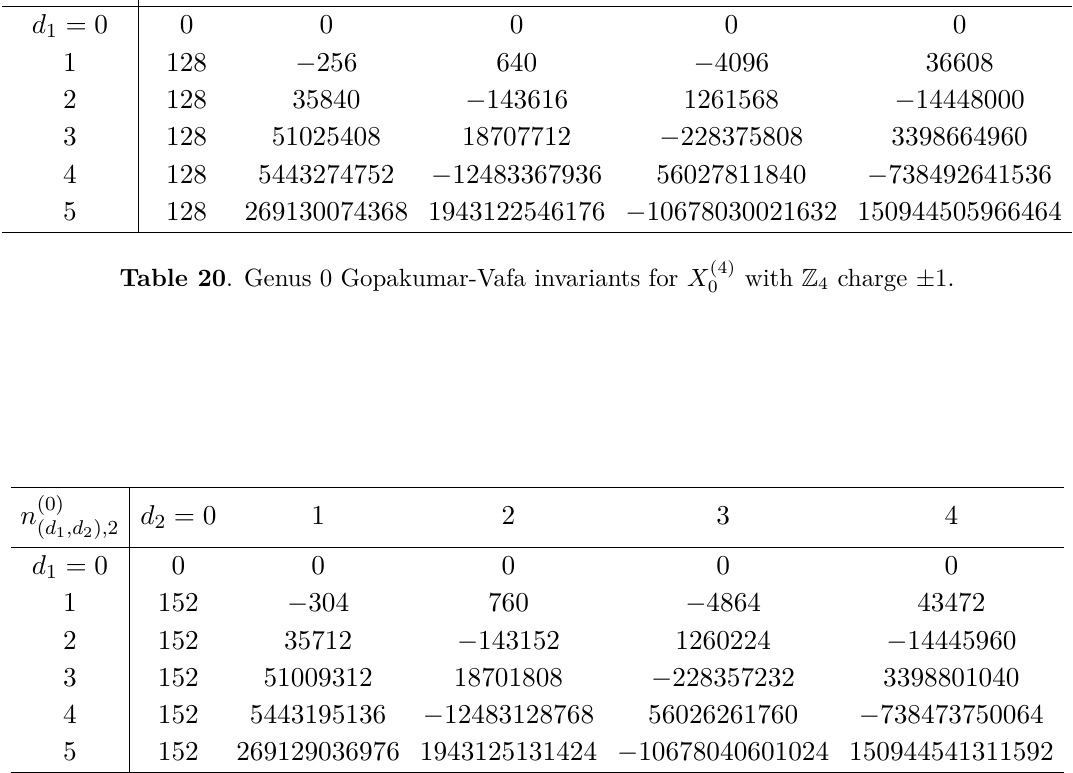
Table 21 . Genus 0 Gopakumar-Vafa invariants for X (4)